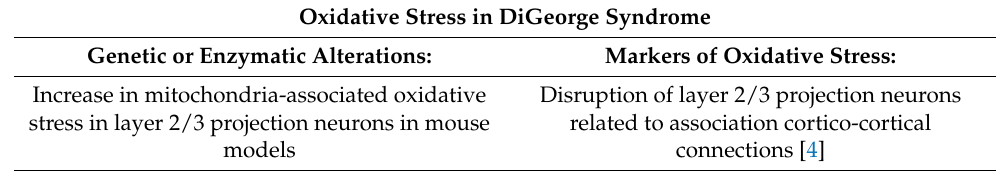
Table 1. Relations between genetic or enzymatic alterations and markers of oxidative stress in patients affected by DGS. Oxidative Stress in DiGeorge Syndrome Genetic or Enzymatic Alterations: Markers of Oxidative Stress: Increase in mitochondria-associated oxidative Disruption of layer 2/3 projection neurons stress in layer 2/3 projection neurons in mouse related to association cortico-cortical connections [4] models Overproduction of modified proteins such as Met sulfoxide from Met, indole-3-lactate from Inhibition of Complex IV, Complex V and Trp and aminomalonate creatine kinase [8] Overproduction of hexoses such as 5-hydroxymethyl-2-furanoic acid and hexuronic acid in children Inhibition of superoxide dismutase 2 (SOD2) [29,30] Loss of DGCR8 gene in animal models Increase in ROS [29,30] Accelerated senescence [29,30] Loss of TXNRD2 gene in children Reduction in antioxidant defense